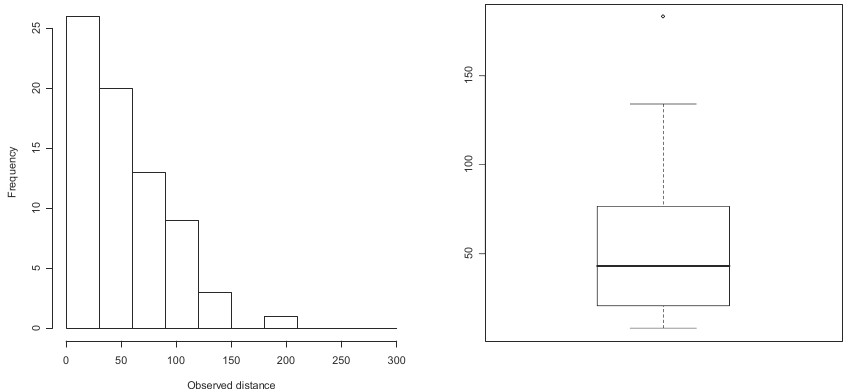
Figure 1 − Distribution of the observed distances for the chipping sparrow data in Pine Juniper shrub